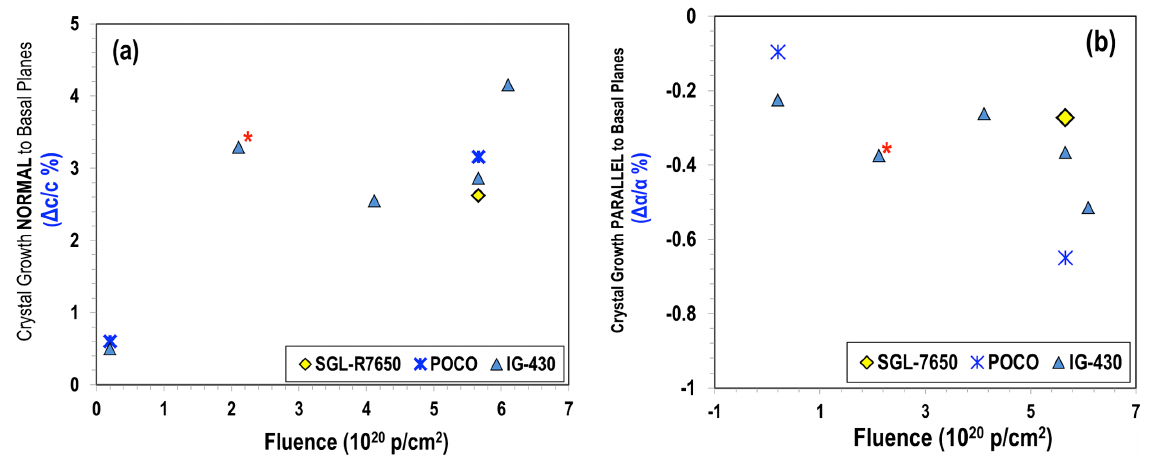
FIG. 19. Dimensional changes in c and a axes of proton-irradiated graphite grades POCO, IG 430 and SGL to fluence up to 6 . 1 × 10 20 p = cm 2 . Asterisks indicate data for irradiation temperature ∼ 150